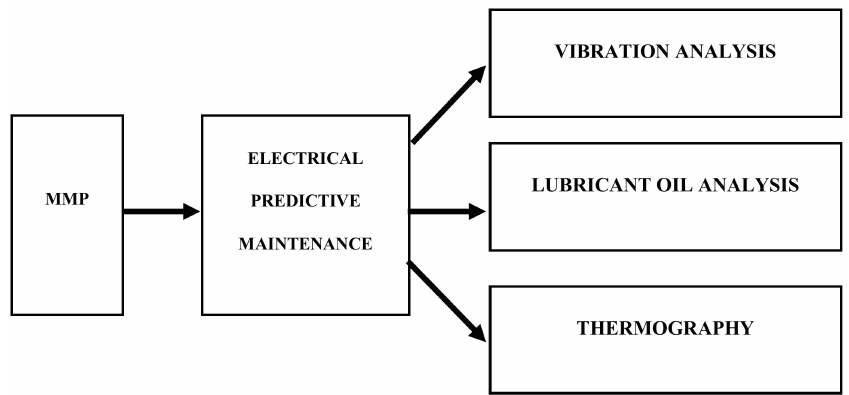
Figure 4. Electrical Predictive Maintenance Methods.